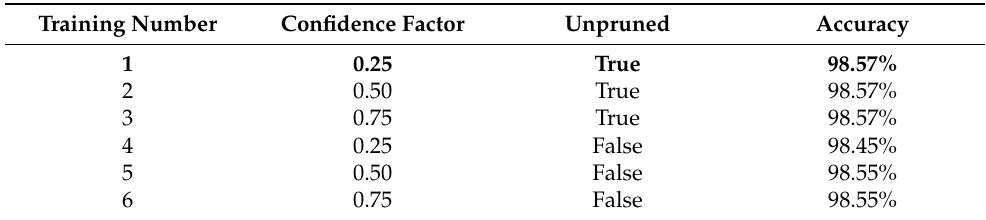
Table 4. J48 DT algorithm hyperparameter optimization results using two as the minimum number of instances present in a leaf.